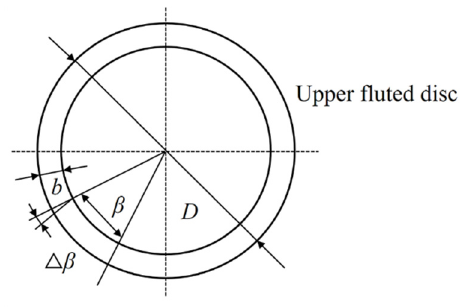
Figure 3. Schematic diagram of the tooth direction error.